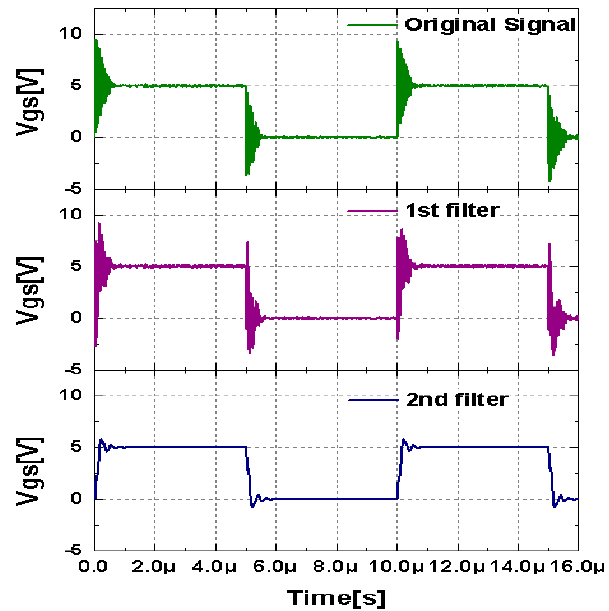
Figure 15. The gate-source voltage signals (original and filtered).